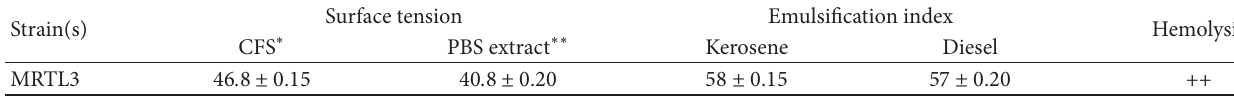
Table 1: Testing of MRTL3 for biosurfactant production by various methods.